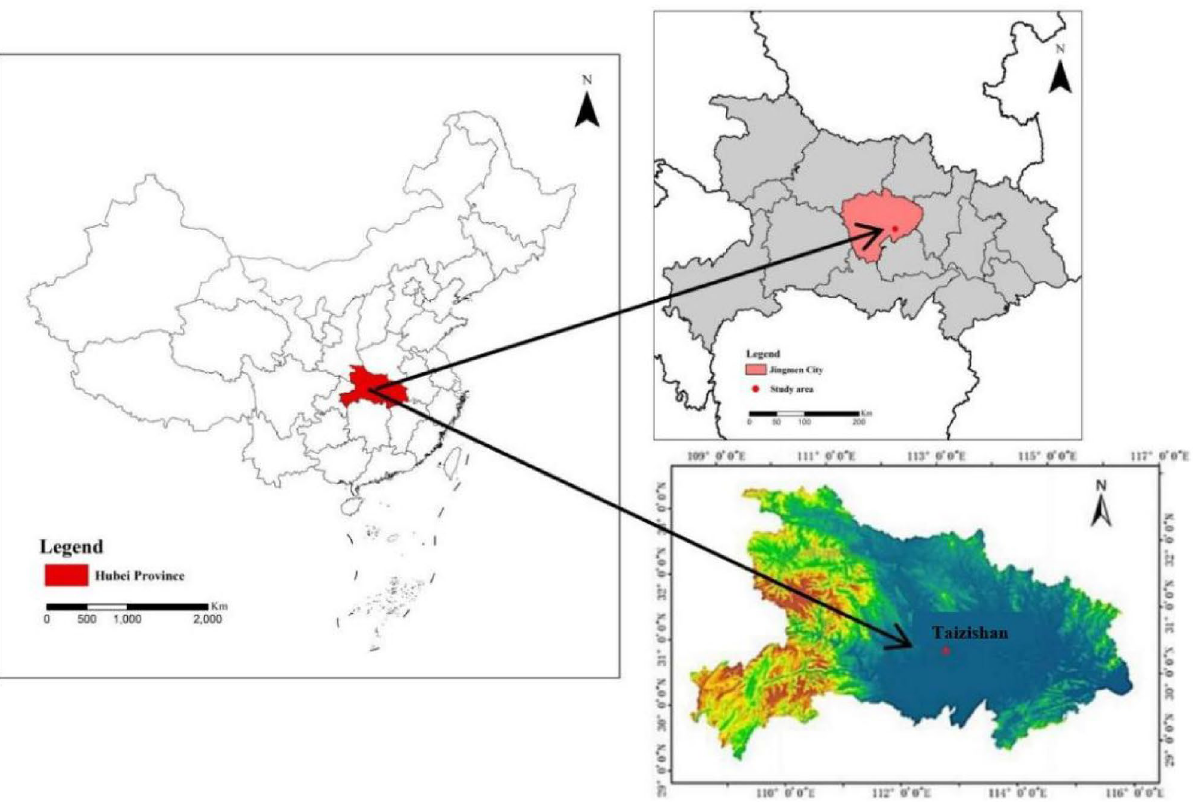
Figure 1. Geographic location of the study area. Maps were generated using ArcGIS 10.8 for Desktop (http:// www. esri. com/ softw are/ arcgis/ arcgis- for- deskt op).